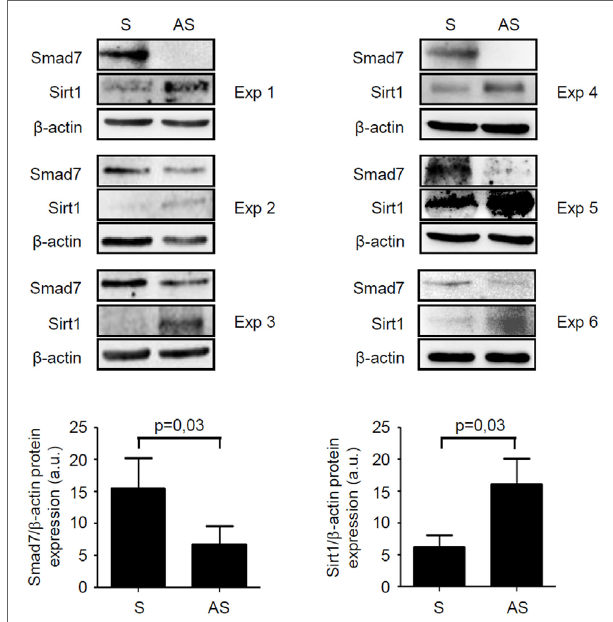
FigUre 5 | Knockdown of Smad7 increases Sirt1 expression in inflammatory bowel disease (IBD) mucosal explants. Blots showing Smad7, Sirt1, and β -actin in total proteins extracted from mucosal biopsy samples of six IBD patients treated with Smad7 sense (S) or antisense (AS) oligonucleotide. Results of each experiment (Exp) are shown. Lower panels show the quantitative analysis of Smad7/ β -actin ratio and Sirt1/ β -actin ratio, respectively, in six IBD patients as measured by densitometry scanning of Western blots. Values are expressed in arbitrary units (a.u.) and indicate mean ± SEM of all